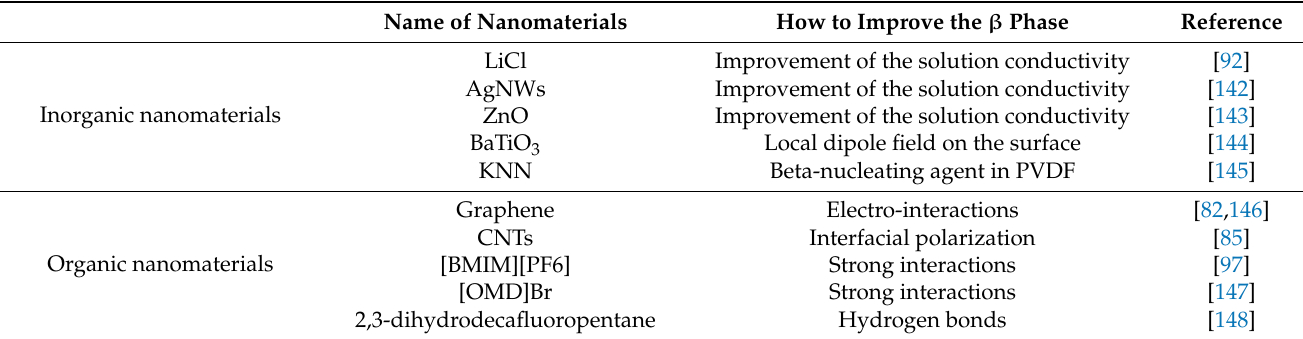
Table 2. Common nanomaterials used to improve the β phase